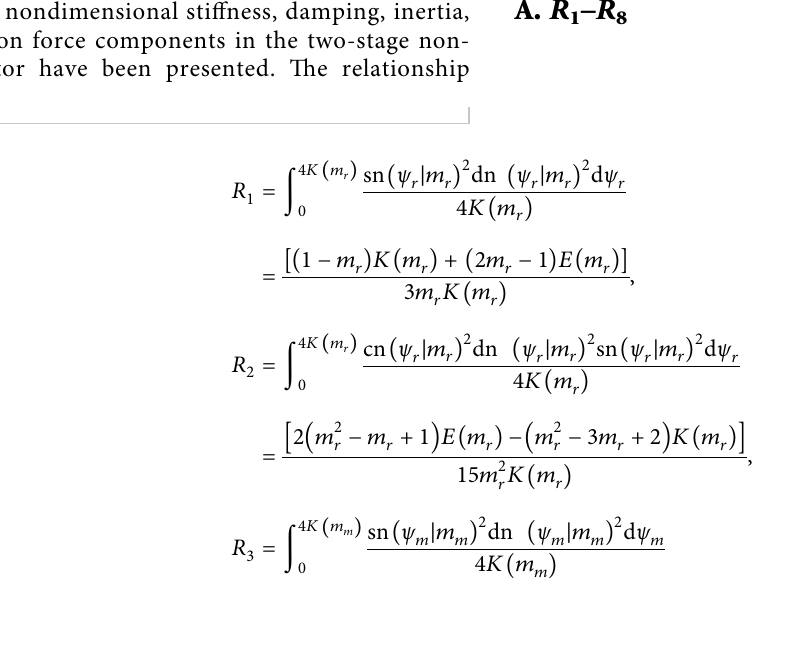
� 0 . 1. Solid line , stable solution by the EHBM; dashed line , e